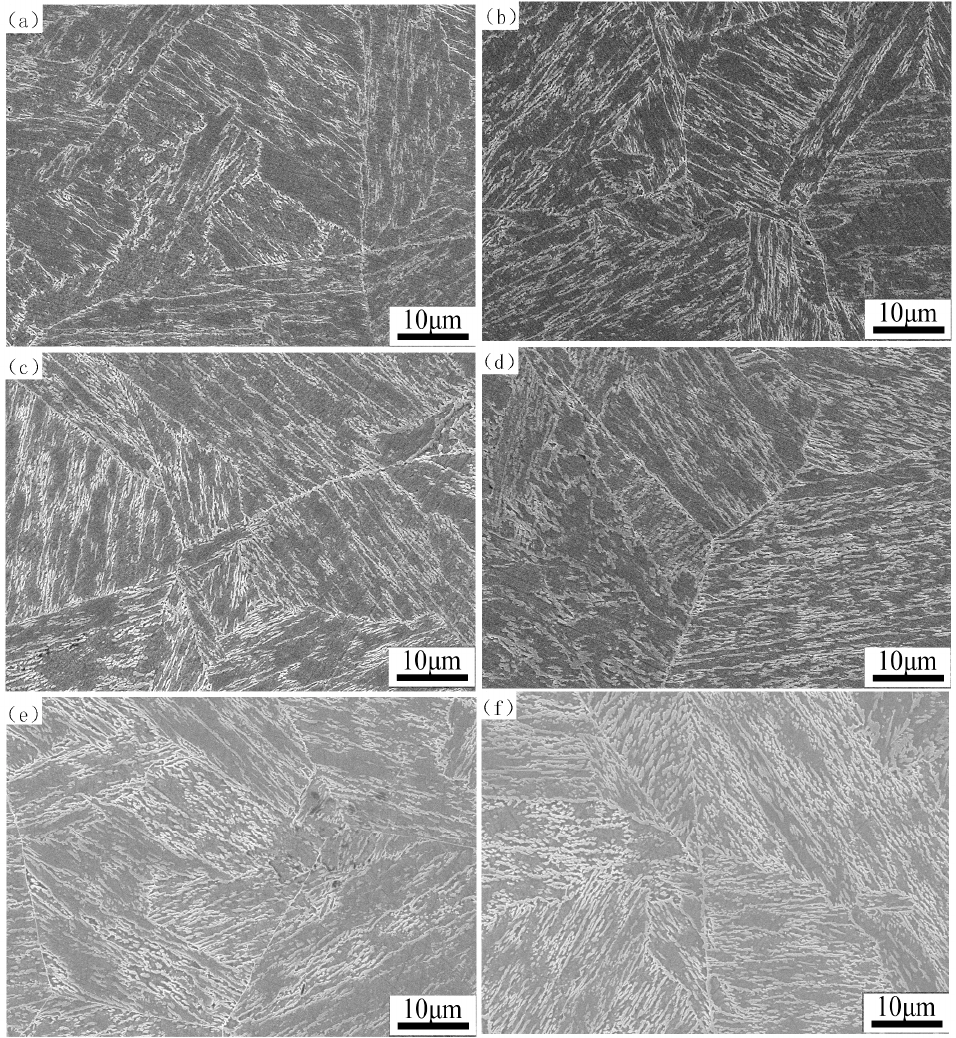
Figure 1. SEM microstructure of the samples tempered at ( a ) 1 h, ( b ) 2 h, ( c ) 4 h, ( d ) 8 h, ( e ) 16 h, and ( f ) 32 h.